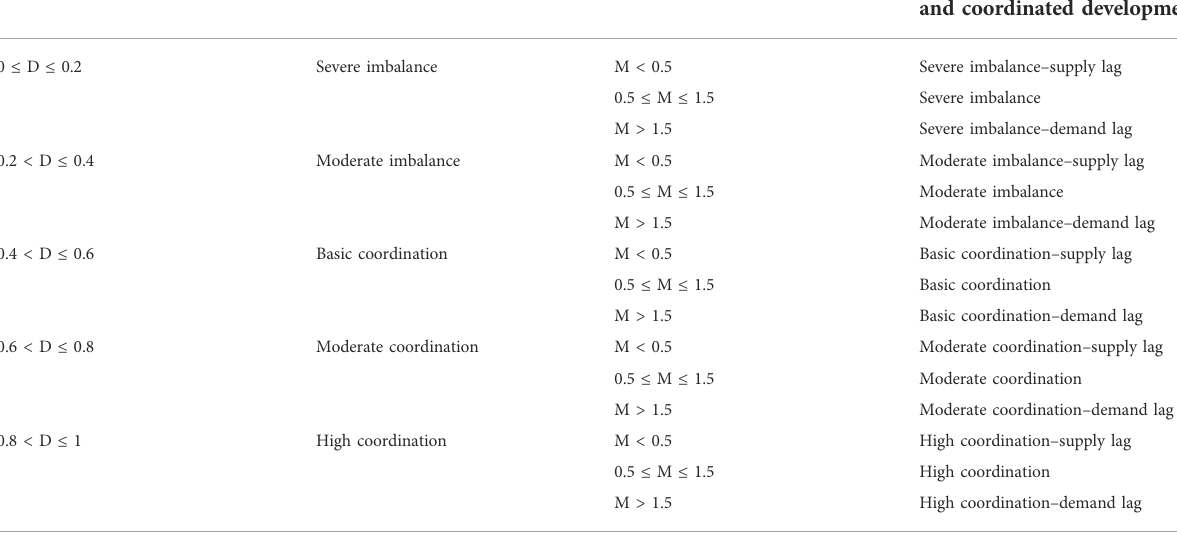
TABLE 3 Types and division criteria of coordinated development of supply and demand coupling of ecosystem